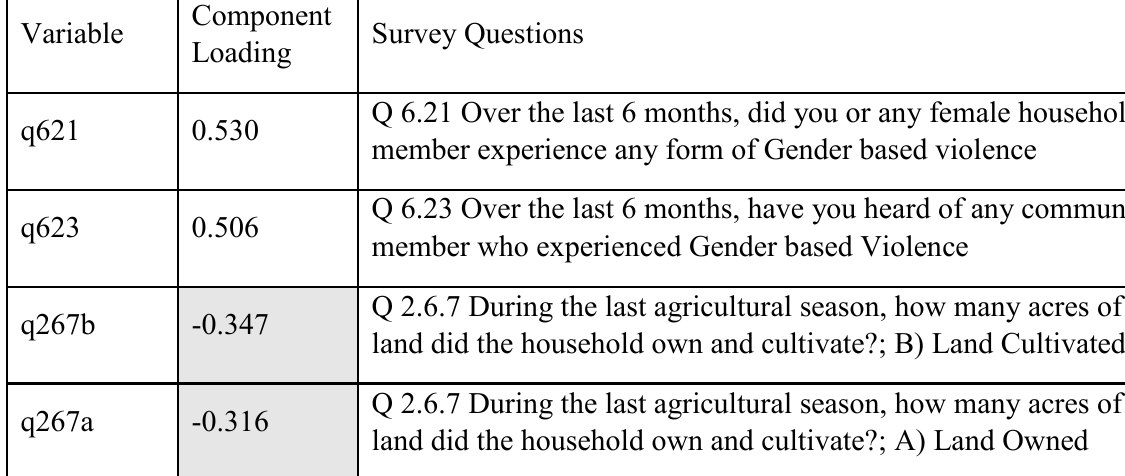
Table 1.48: Variables defining Transformative Resilience PC5